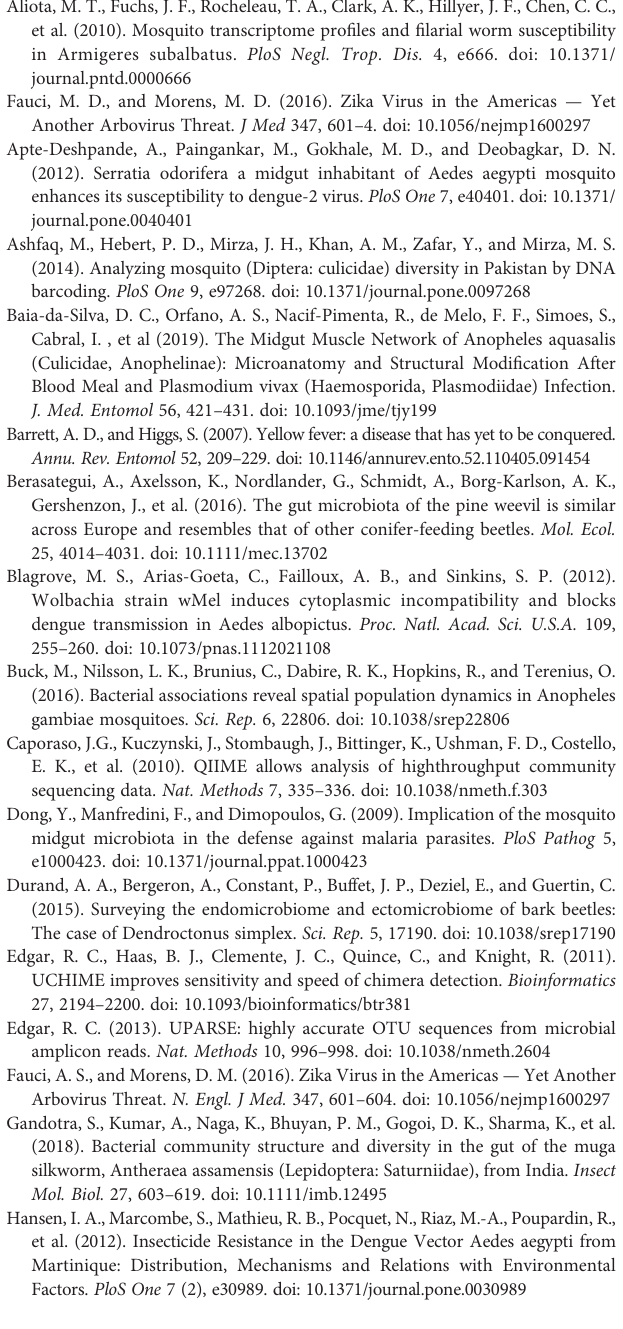
SUPPLEMENTARY FIGURE 1 | Relative abundance of the top 43 bacterial genera in all samples from different study sites. DA = Dingan, HK = Haikou,